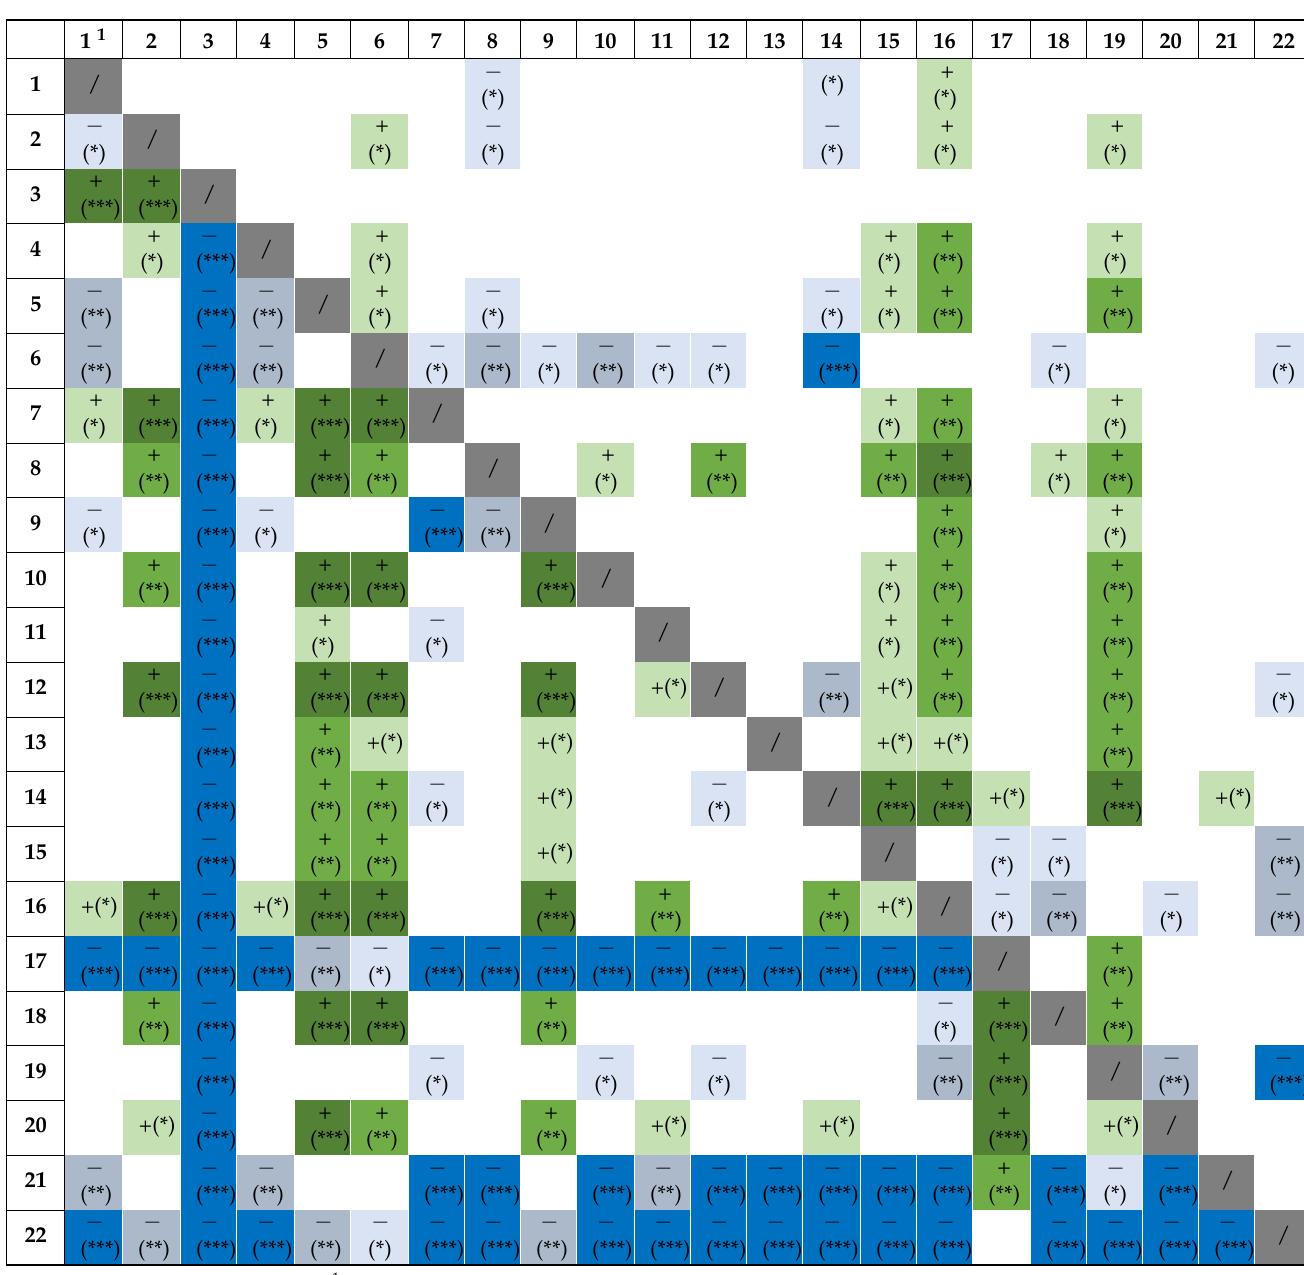
Table 10. The comparison of boat types’ influence on pacing strategy between Q1 and